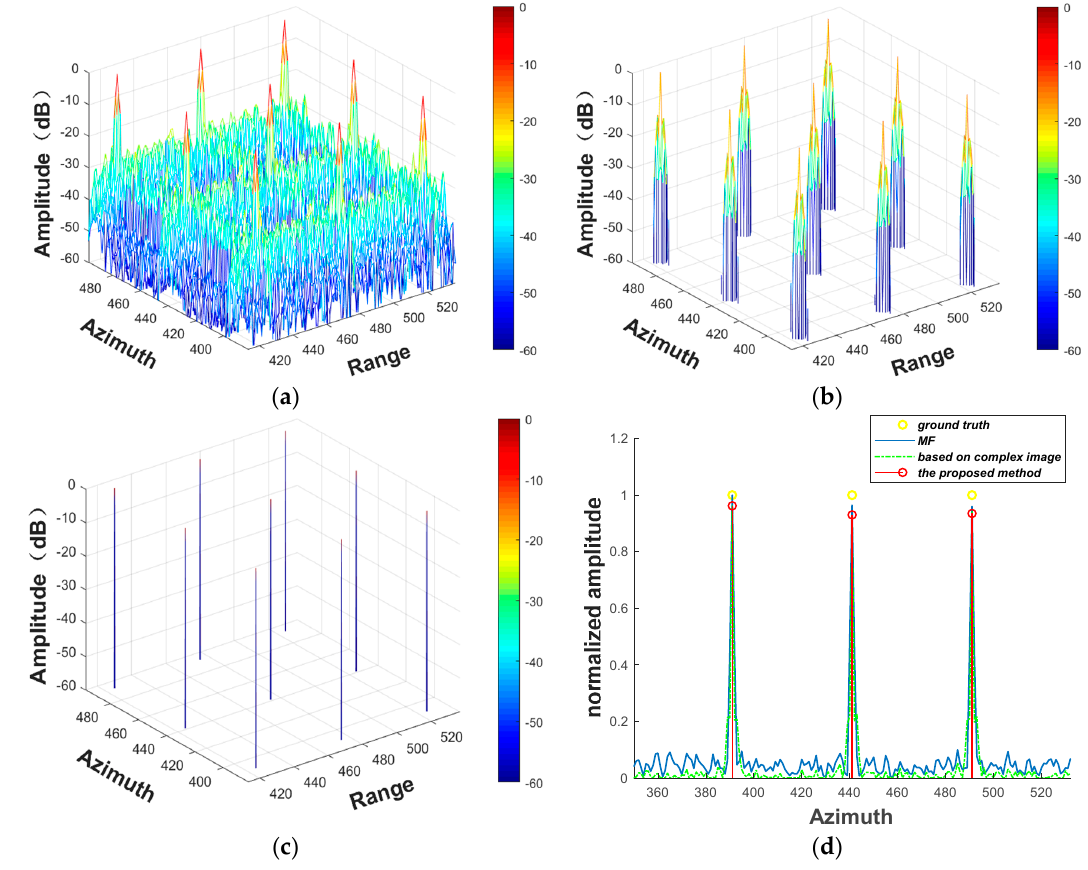
Figure 3. 2D simulation results. ( a ) The reconstructed images obtained by MF. ( b ) The image reconstructed by parameter estimation method based on complex image. ( c ) The image reconstructed by the proposed method. ( d ) The azimuth profile. Table 2. Major parameters.